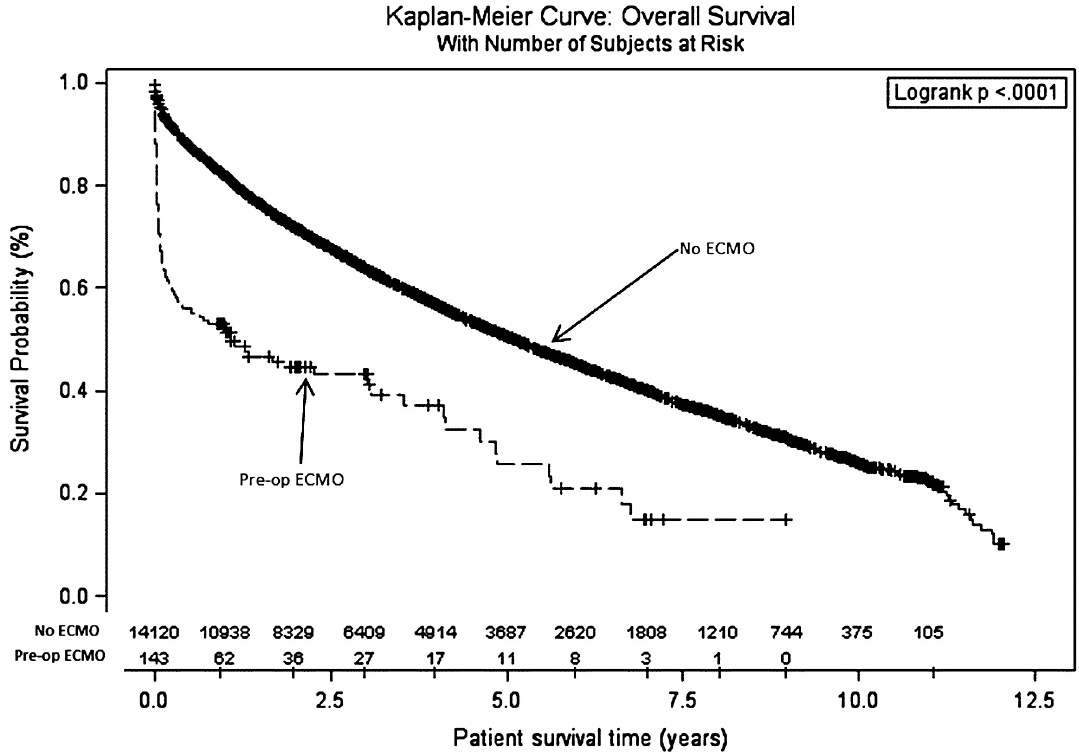
Figure 1. Kaplan – Meier Curve: Comparing survivals of patients on pretransplant ECMO with those that were not on ECMO.